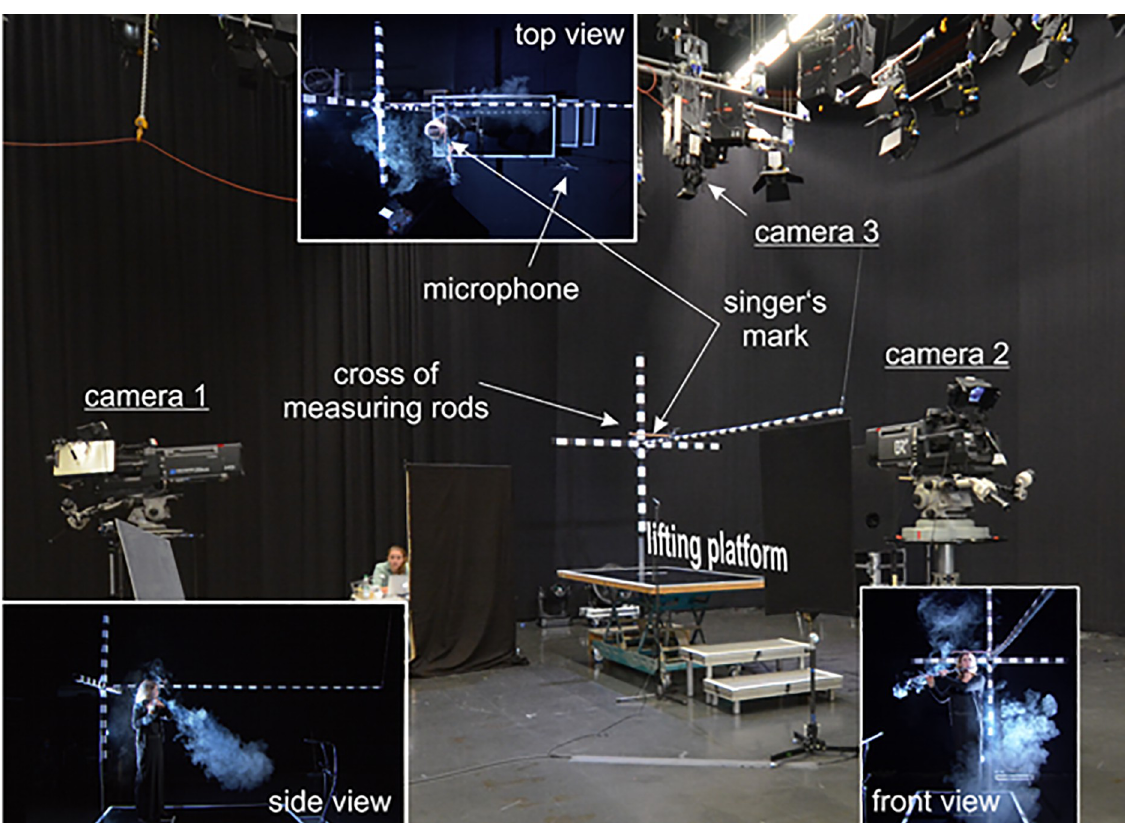
Fig 1. Picture of the test setup including the three cameras, the lifting platform and measuring rod cross (spatial directions are indicated by x, y and z). The perspective views of each camera are shown with a musician in performing